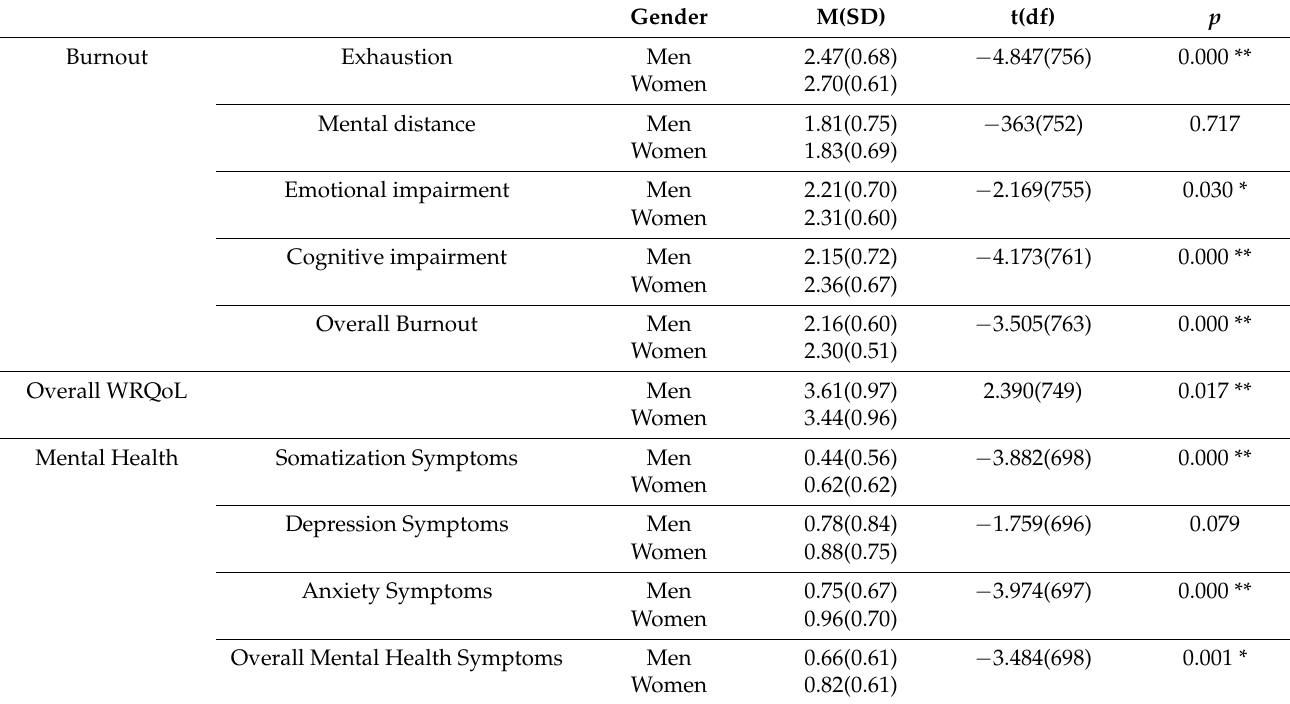
Table 2. Results for Burnout, Overall Work-Related Quality of Life and Mental Health Symptoms by Gender.